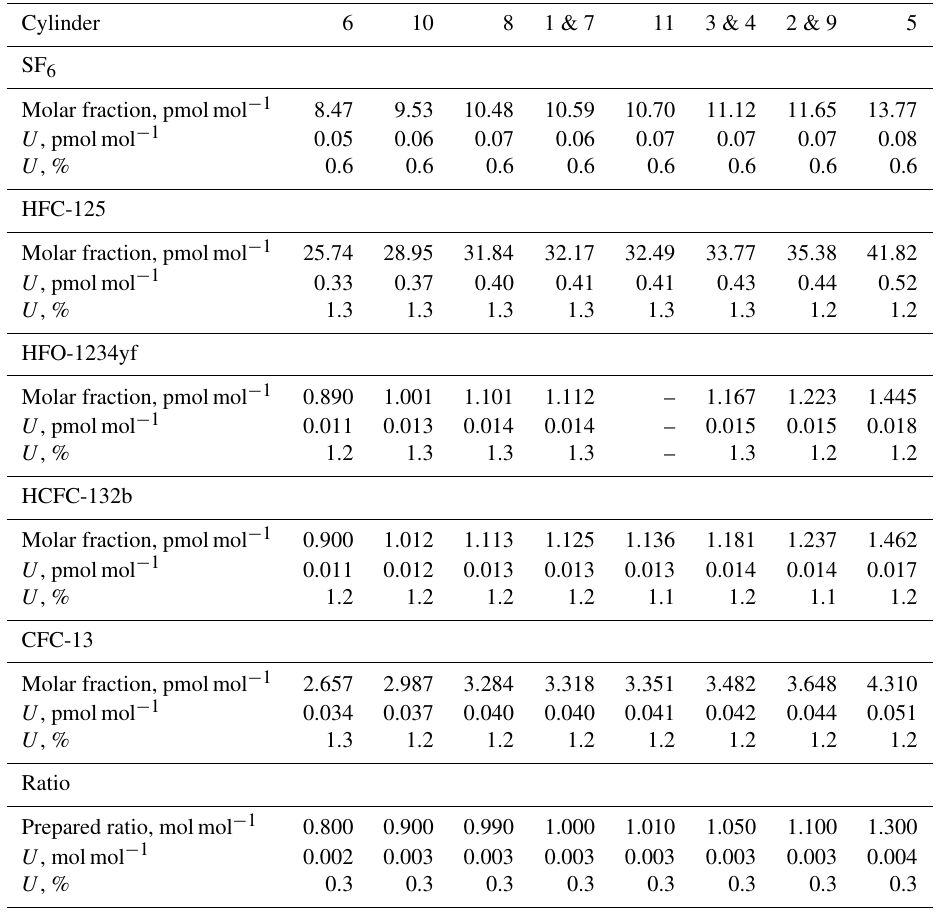
Table 3. METAS-2017 suite of reference gas mixtures: prepared ratios and molar fractions and associated uncertainty with a 95% confidence interval. Molar fractions for halogenated compounds are expressed in dry synthetic air. Ratios represent the number of moles of substance i in cylinder j divided by the number of moles of the same substance in cylinder MP-001. R prep ,i,j is therefore a molar ratio. Prepared ratios are identical for all substances within a given cylinder and thus only one value per cylinder is reported here. Note: HFO-1234yf was not filled in cylinder MP-011.